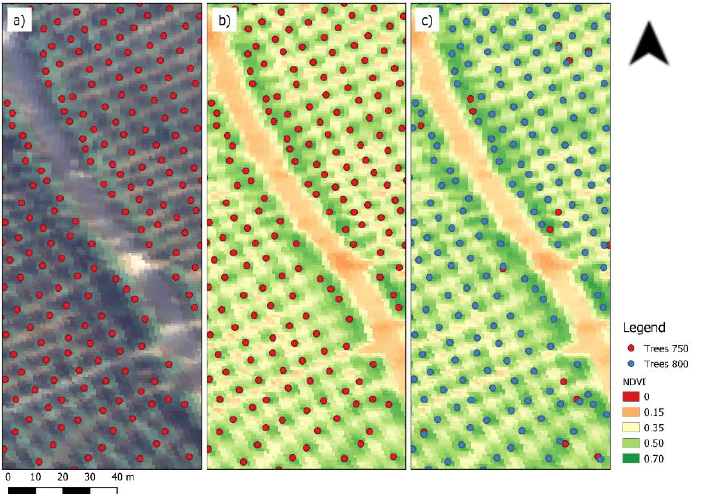
Figure 4. Tree points (red) derived using NDVI with band 750, overlaying ( a ) the hyperspectral image, and ( b ) the NDVI-derived using band 750, and ( c ) tree points derived using band 800 (blue) in comparison NDVI 750 points, overlying NDVI-derived using band 800.